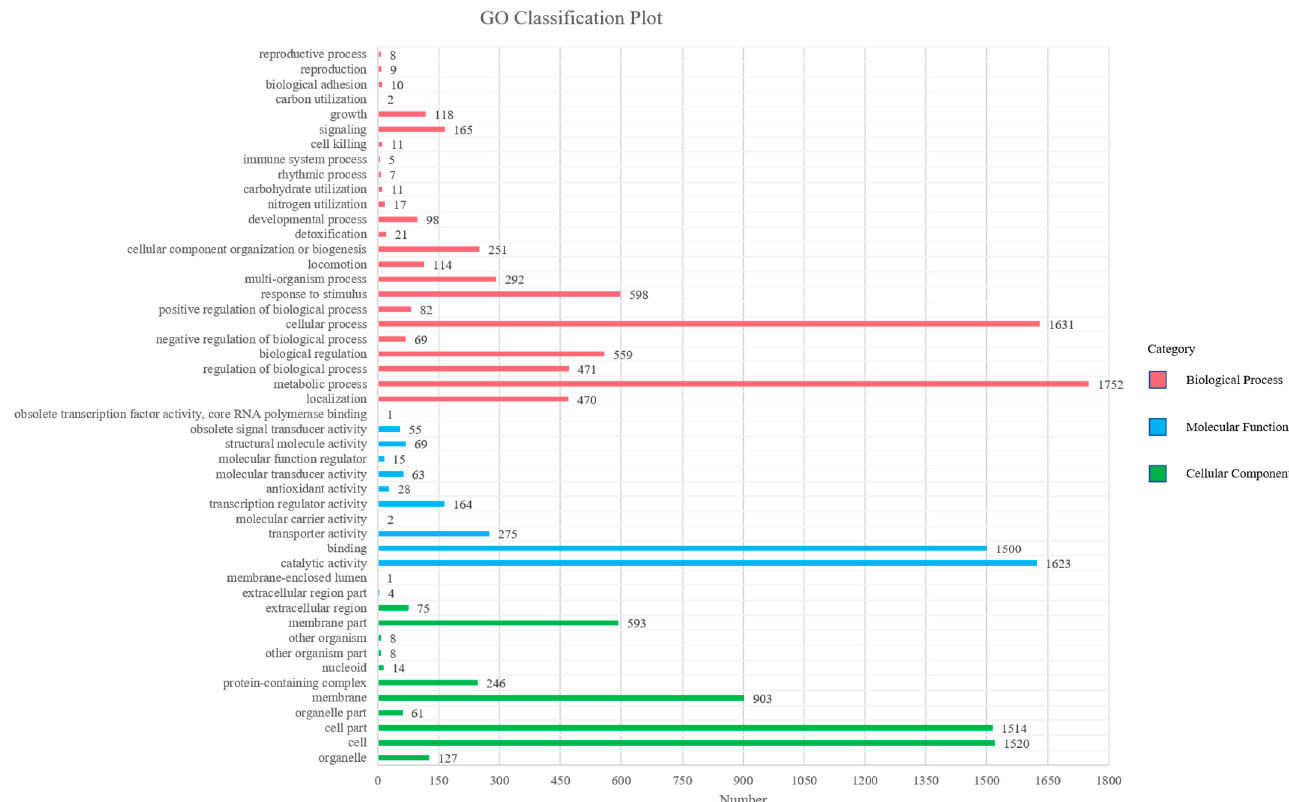
Figure 2. Distributions of second level GO of Sphingomonas morindae sp. NBD5 genome sequence. The y -axis indicates the GO ontology; the x -axis represents the number of unigenes in a category.